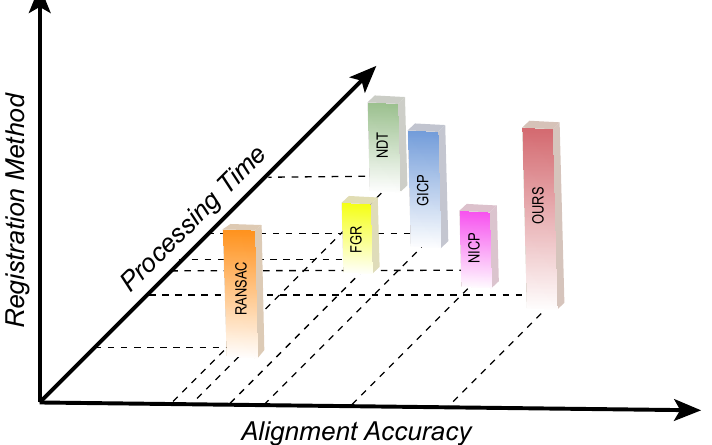
Figure 2. Performance comparison of different algorithms. We conduct a comprehensive comparison of the different registration methods separately using processing time and alignment accuracy as the judging criteria. While some methods are faster in terms of processing time, others are more accurate. Collectively, our proposed approach achieves a balance between these two aspects and performs well in terms of